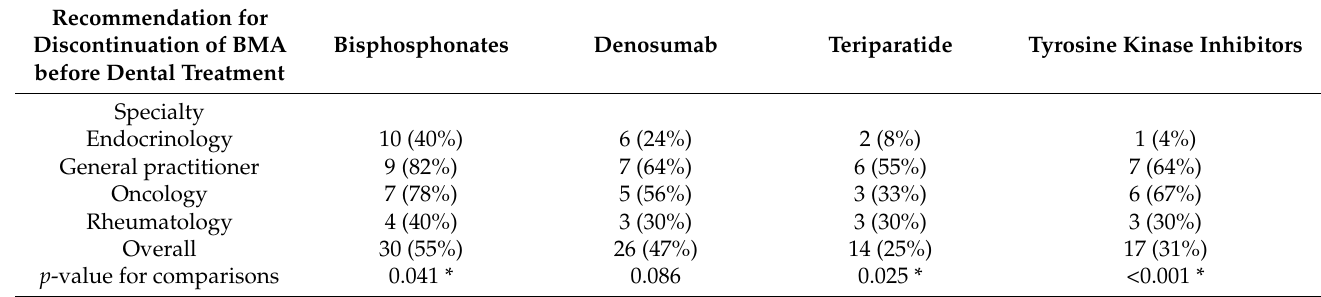
Table 6. Recommendations for discontinuation of BMAs before dental treatment and comparisons between specialties. Significant differences are marked with